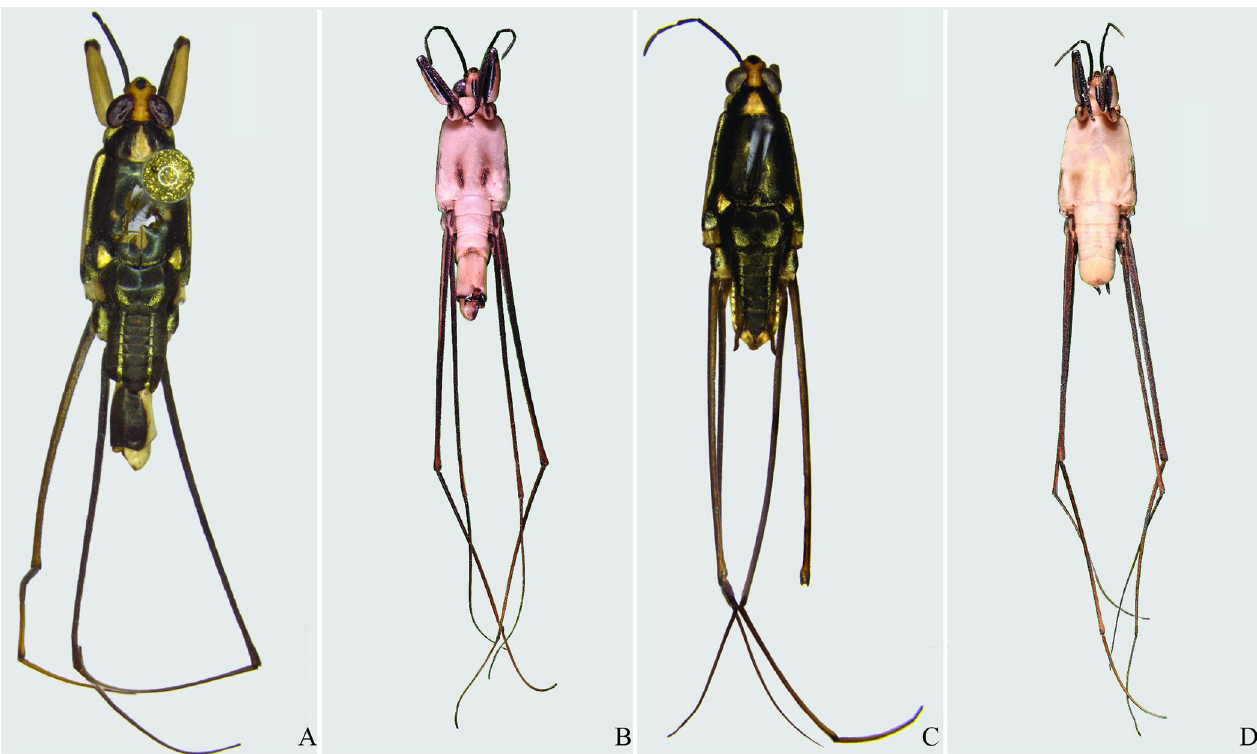
Fig 14. Potamobates carvalhoi . (A) Male, dorsal view; (B) male, ventral view; (C) female, dorsal view; (D) female, ventral view.